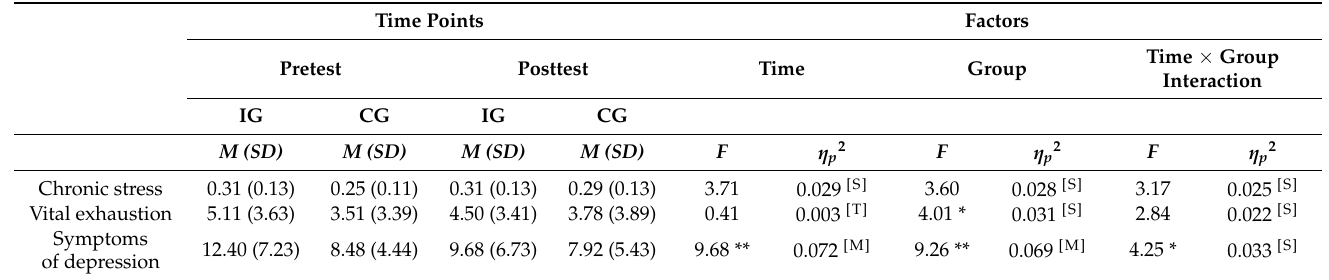
Table 2. Descriptive and inferential statistical indices for chronic stress, vital exhaustion and symp- toms of depression, at pre- and posttest, separately for the intervention and control